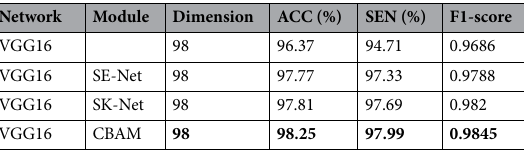
Table 5. Recognition results with different attention modules embedded. Significant values are in bold.